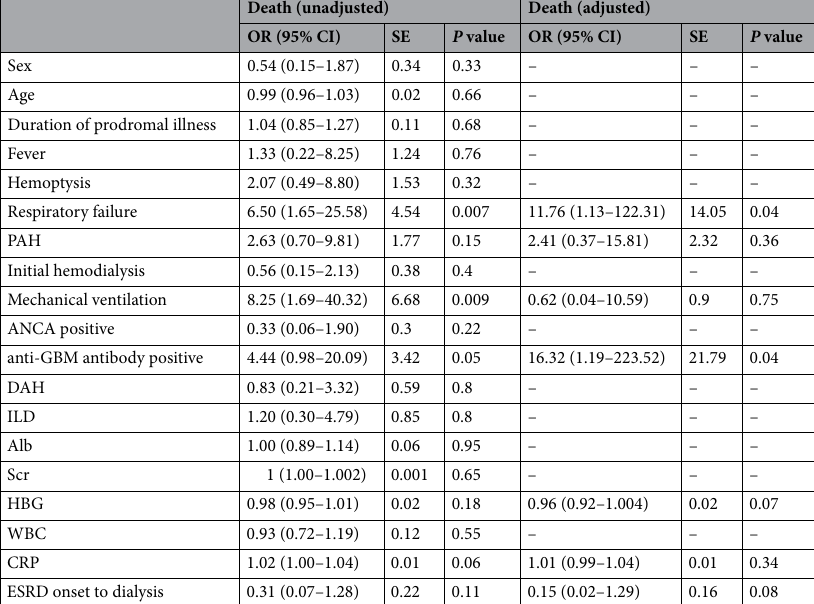
Table 2. Prognostic factors for the death of PRS patients. Variates of p value <0.2 were enrolled in multivariate analysis. Adjusted for respiratory failure, PAH, mechanical ventilation, anti-GBM antibodies, HBG, CRP and ESRD to